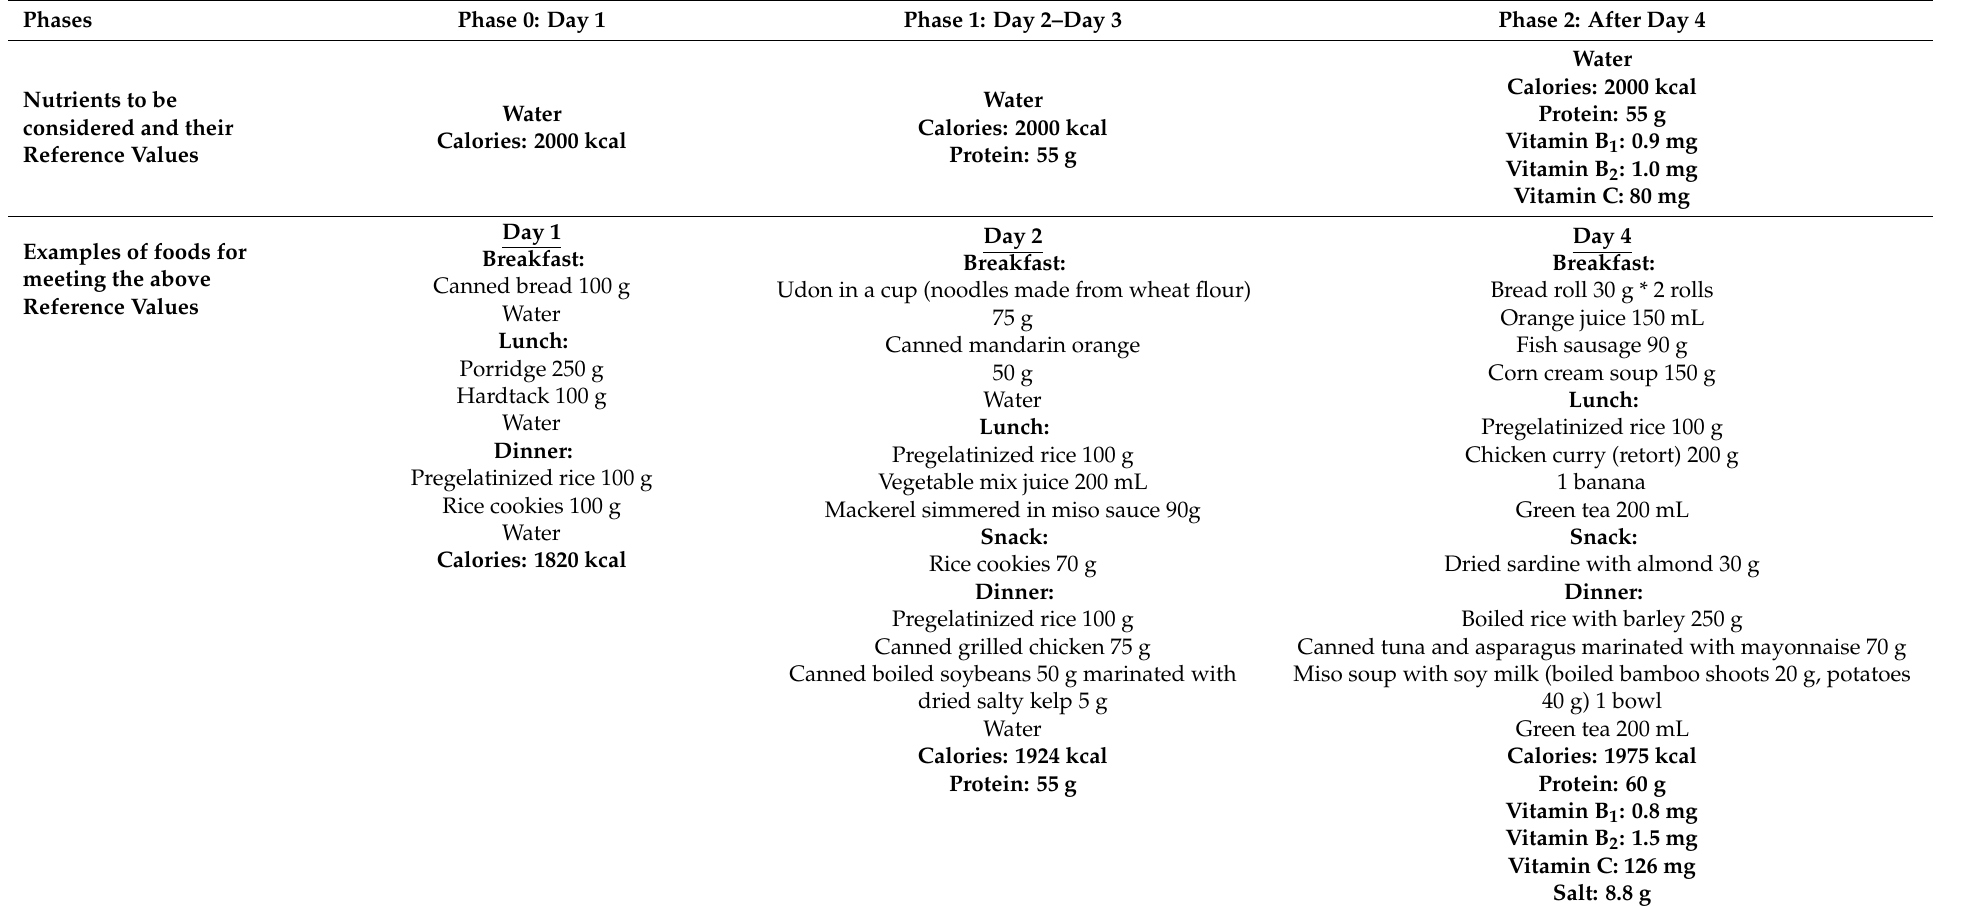
Table 14. Examples of foods for meeting the new Reference